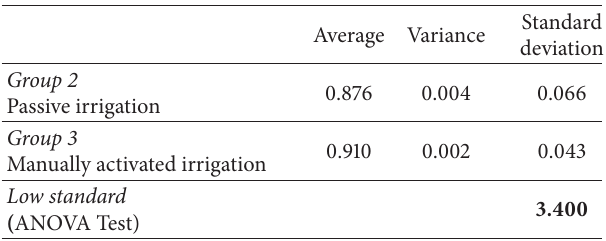
Table 2: Comparative analysis of average values of infiltration between group 2 and group